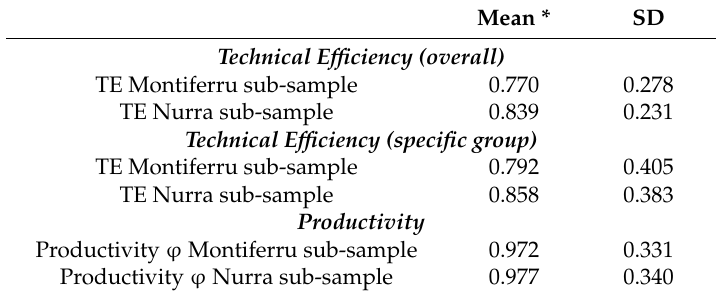
Table 3. Overall and specific (group) technical efficiency, productivity and scale efficiency.